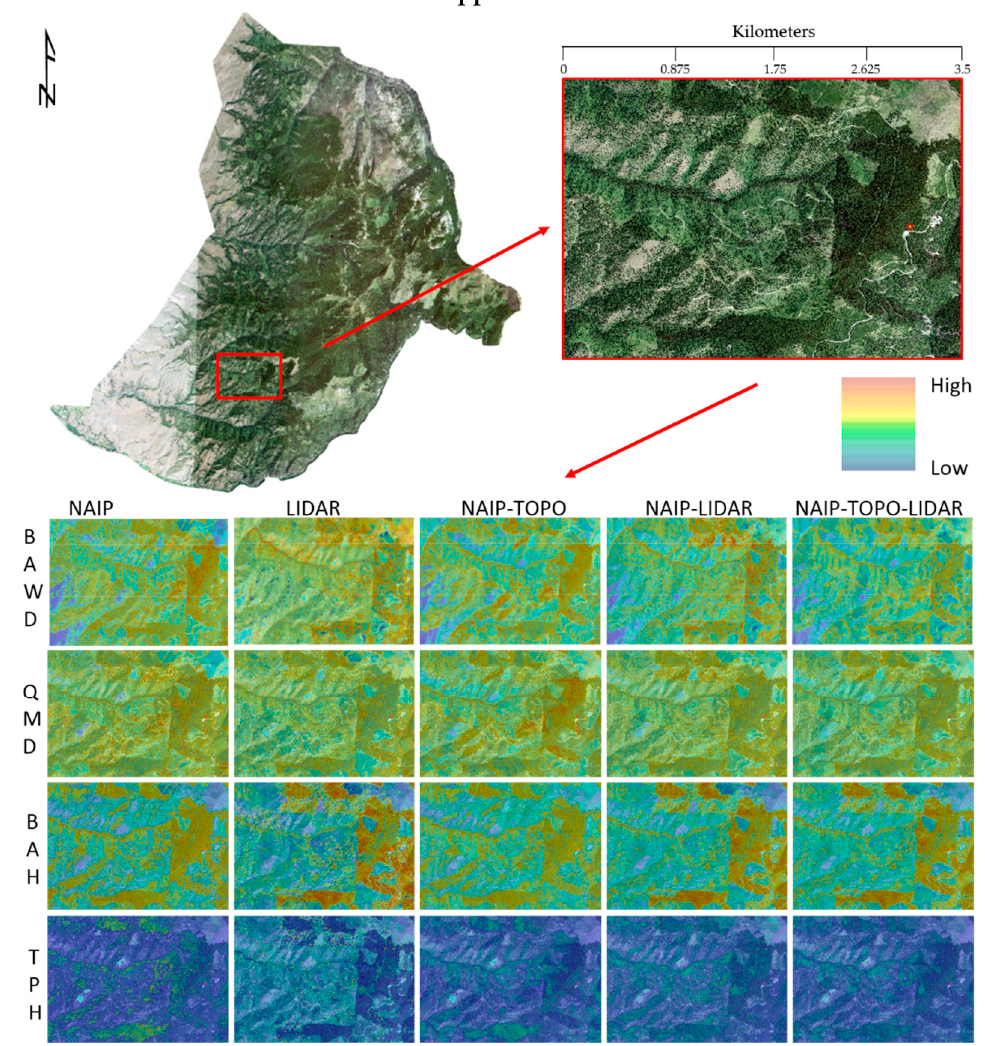
Figure A1. Example of minor differences in basal area weighted diameter (BAWD with field measured min: 0.00 cm, and max: 58.62 cm), quadratic mean diameter (QMD, with field measured min: 1.27 cm, and max: 53.34 cm), basal area per hectare (BAH with field measured min: 0.00 cm, and max: 45.22 cm), and trees per hectare (TPH with field measured min: 0.00, and max: 41,439.54) estimated values for NAIP, LiDAR and TOPO based models. Additional summary statistics are given in Table A1.